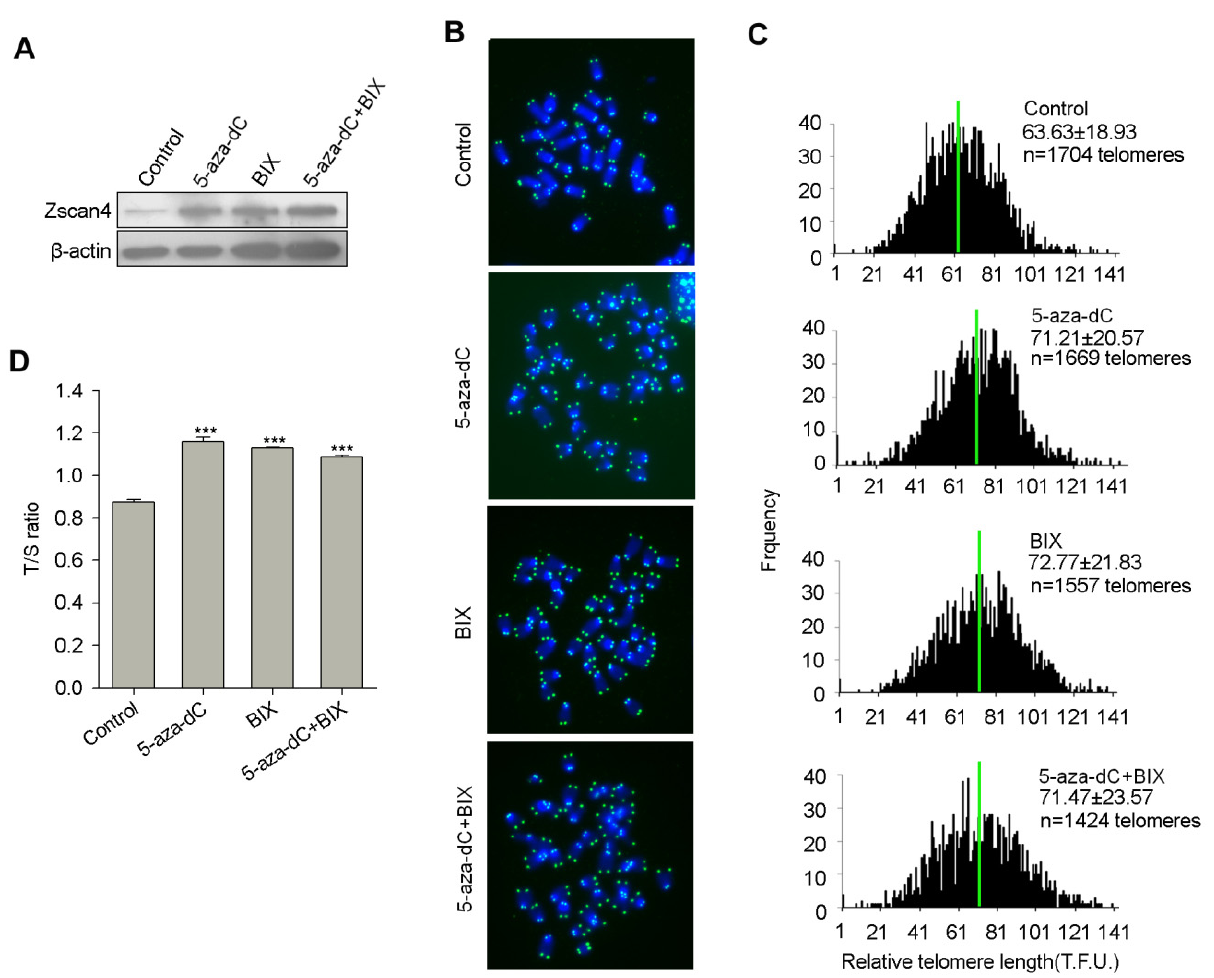
Figure 4. Inhibition of DNA methylation and H3K9 methylation elevates Zscan4 expression levels and elongates telomere lengths. ( A ) Western blotting analysis shows increased Zscan4 protein levels after treatment with small molecules. 5 ‐ aza ‐ dC, DNA methyltransferases (DNMTs) inhibitor; BIX ‐